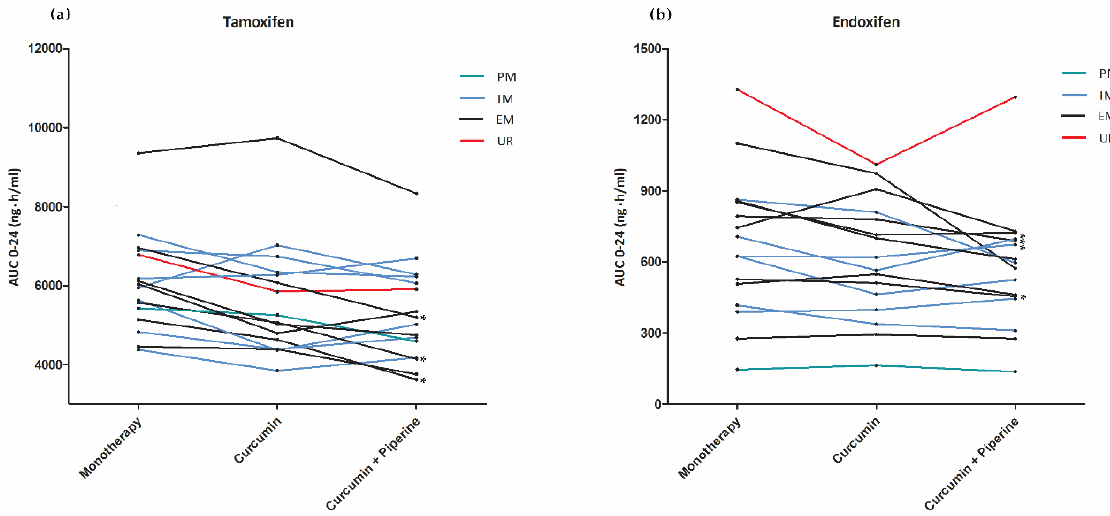
Figure 2. Endoxifen and tamoxifen AUC 0–24h per individual patient per treatment phase: ( a ) Tamoxifen AUC 0–24h per individual patients per treatment phase. ( b ) endoxifen AUC 0–24h per individual patients per treatment phase. Patients with an intermediate CYP2D6 metabolism (IM) were colored blue. 137